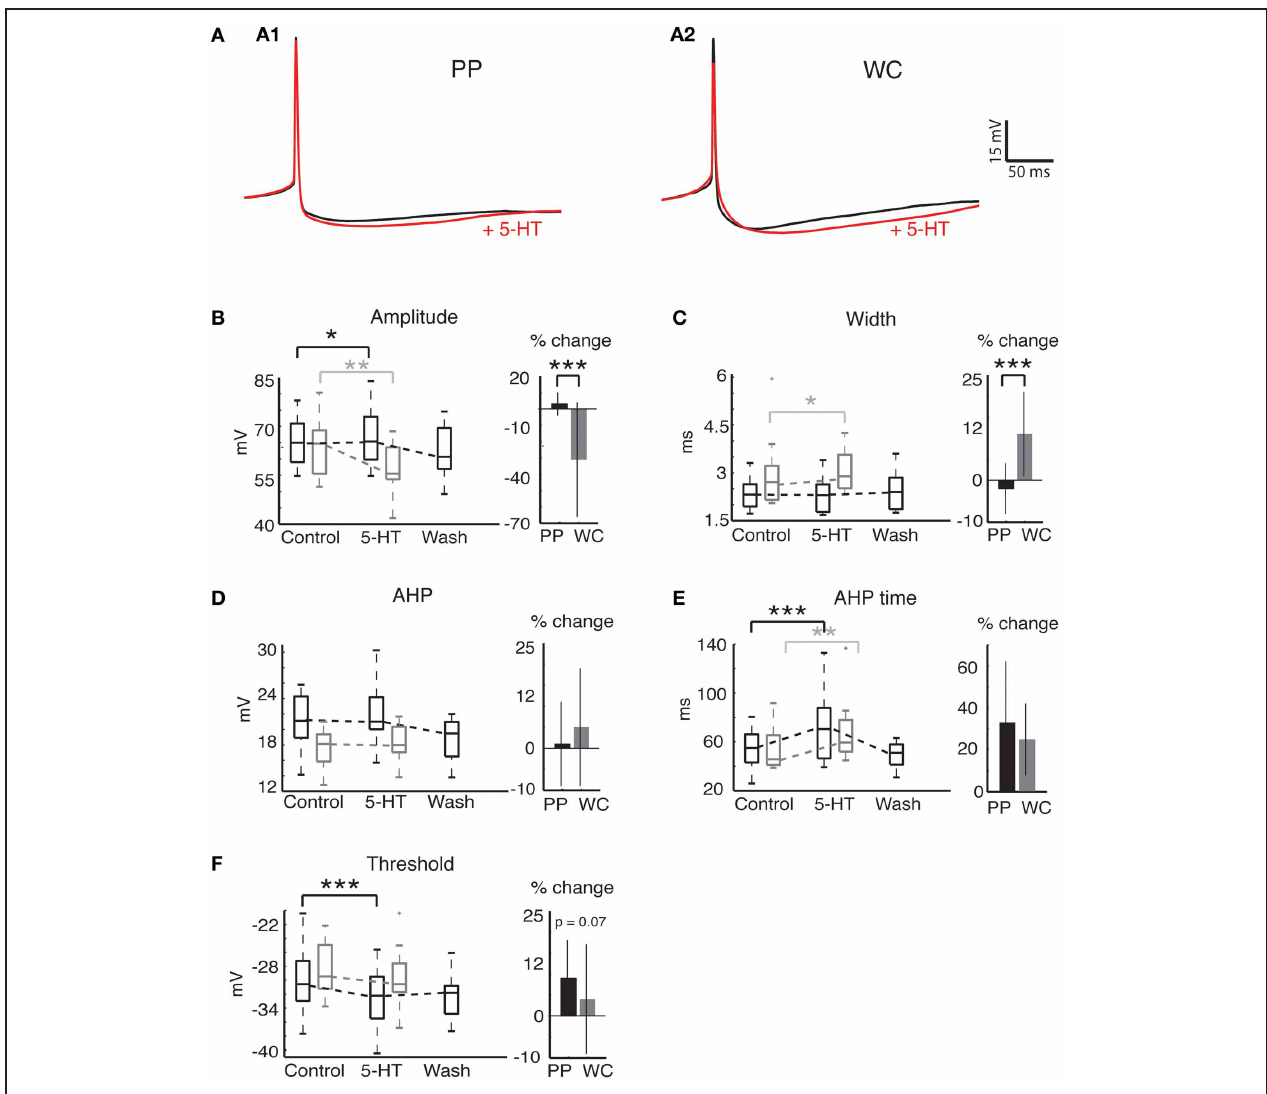
became significantly larger in WCR. The amount of change was significantly different for PPR versus WCR. (D) The AHP amplitude did not change significantly with either recording method. (E) The AHP time increased significantly in both recording methods, but the amount of change was not significantly different for PPR versus WCR. (F) The AP threshold became significantly more hyperpolarized in PPR but did not change significantly in WCR. The amount of change was not significantly different for PPR versus